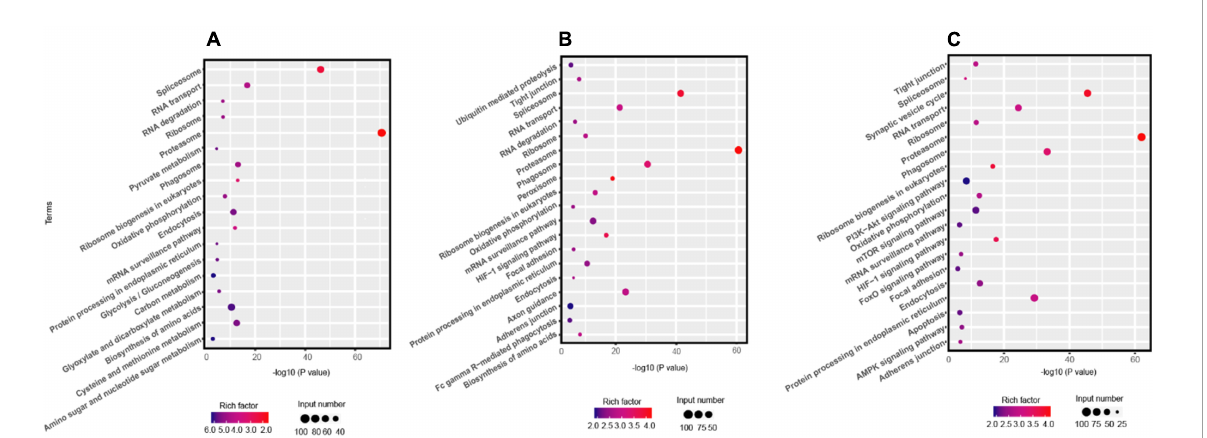
FIGURE3 The DEGs for secondary metabolites production. (A) The biosynthetic pathway for PAA production, including the five key synthetases (shikimate kinase, EPSP synthase, chorismate synthase, prephenate dehydrogenase, and prephenate dehydratase) of PAA and six synthetic compounds associated with shikimate 3-phosphate, 5-O-(1-carboxyviny)-3-phosphoshikimate, chorismite, prehenate, phenyl-pyruvate, PAA. (B) The expression patterns of candidate genes on the five key synthetases of PAA biosynthetic pathway. The heatmap describes the expression of candidate genes (RPKM in log2-scale) associated with shikimate kinase, EPSP synthase, chorismate synthase, prephenate dehydrogenase, and prephenate dehydratase. The red circles next to the heatmap were candidate genes tested by qRT-PCR. (C) The expression patterns of candidate genes on DMATSs and PKSs. The heatmap describes candidate gene expression of DMATSs and PKSs.